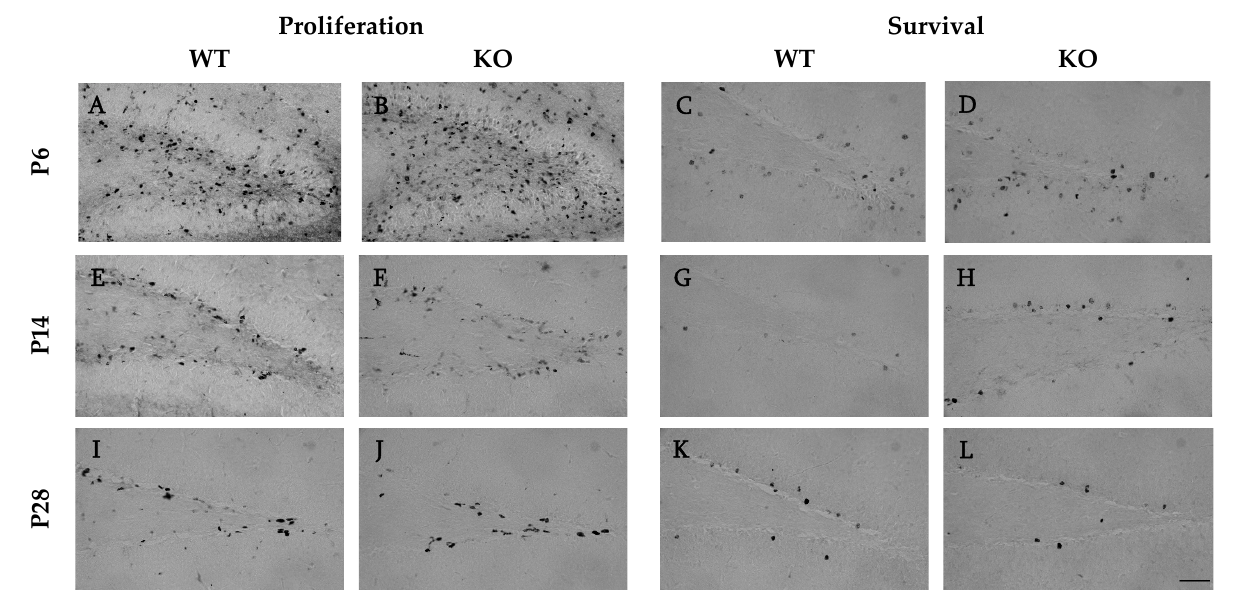
Figure 2. Photomicrographs of diaminobenzidine (DAB)-stained BrdU + cells in the dentate gyrus of the hippocampus of animals injected with BrdU. Representative sagittal sections from a ( A ) WT and ( B ) ZnT3 KO mouse in the P6 proliferation group, ( C ) WT and ( D ) ZnT3 KO mouse in the P6 survival group, ( E ) WT and ( F ) ZnT3 KO mouse in the P14 proliferation group, ( G ) WT and ( H ) ZnT3 KO mouse in the P14 survival group, ( I ) WT and ( J ) ZnT3 KO mouse in the P28 proliferation group, and ( K ) WT and ( L ) ZnT3 KO mouse in the P28 survival group. All photomicrographs were taken at 40 × magnification. Scale bar = 50 µ